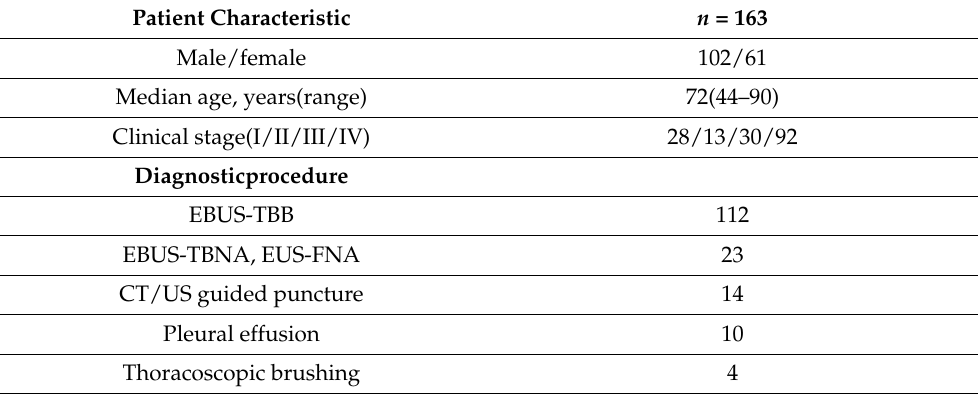
Table 1. Patient characteristics. EBUS-TBB: Endobronchial ultrasonography-guided transbronchial brushing. EBUS-TBNA: Endobronchial ultrasonography-guided transbronchial needle aspiration. EUS-FNA: Endoscopic ultrasound-guided fine needle aspiration. CT: Computed tomography. US: